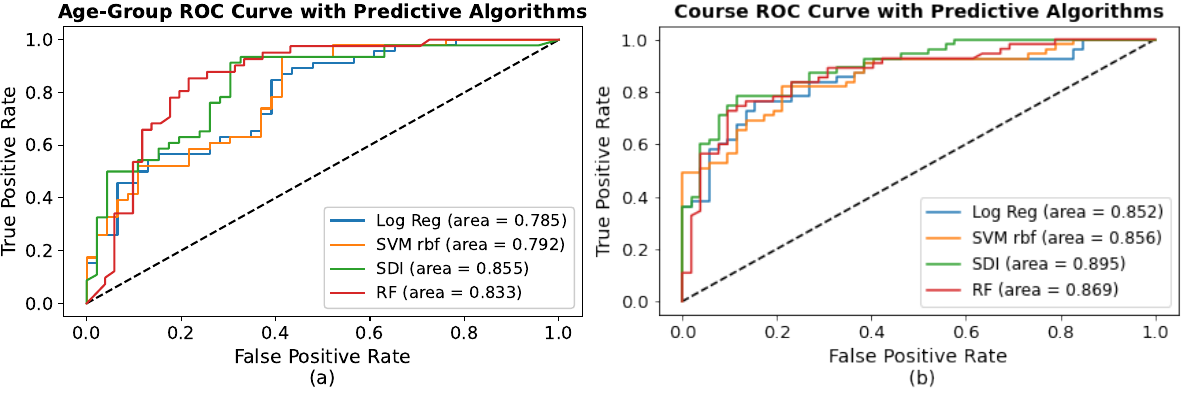
Figure 9. Improved Area Under Curve (AUC) by the SDI Algorithm for: ( a ) Age-Group; ( b ) Course. Figure 10a indicates that the RF model has scored the highest AUC value of 0.873 com- pared to others. The highest value supported the relevance of this model and demonstrated that it more accurately predicted whether a student would be a male or a female student. The RF model initiates sensing at 0.2 and ends up at 0.98. At a threshold of 0.5, the RF has the highest TP rate of 0.98, and R-SVM and LR have an identical TP rate of 0.62, proving the more predictive power of the RF model compared to LR and R-SVM. In addition, in Figure 10b, the RF and R-SVM model attained the identical AUC score of 1.0 to predict the student’s institution.